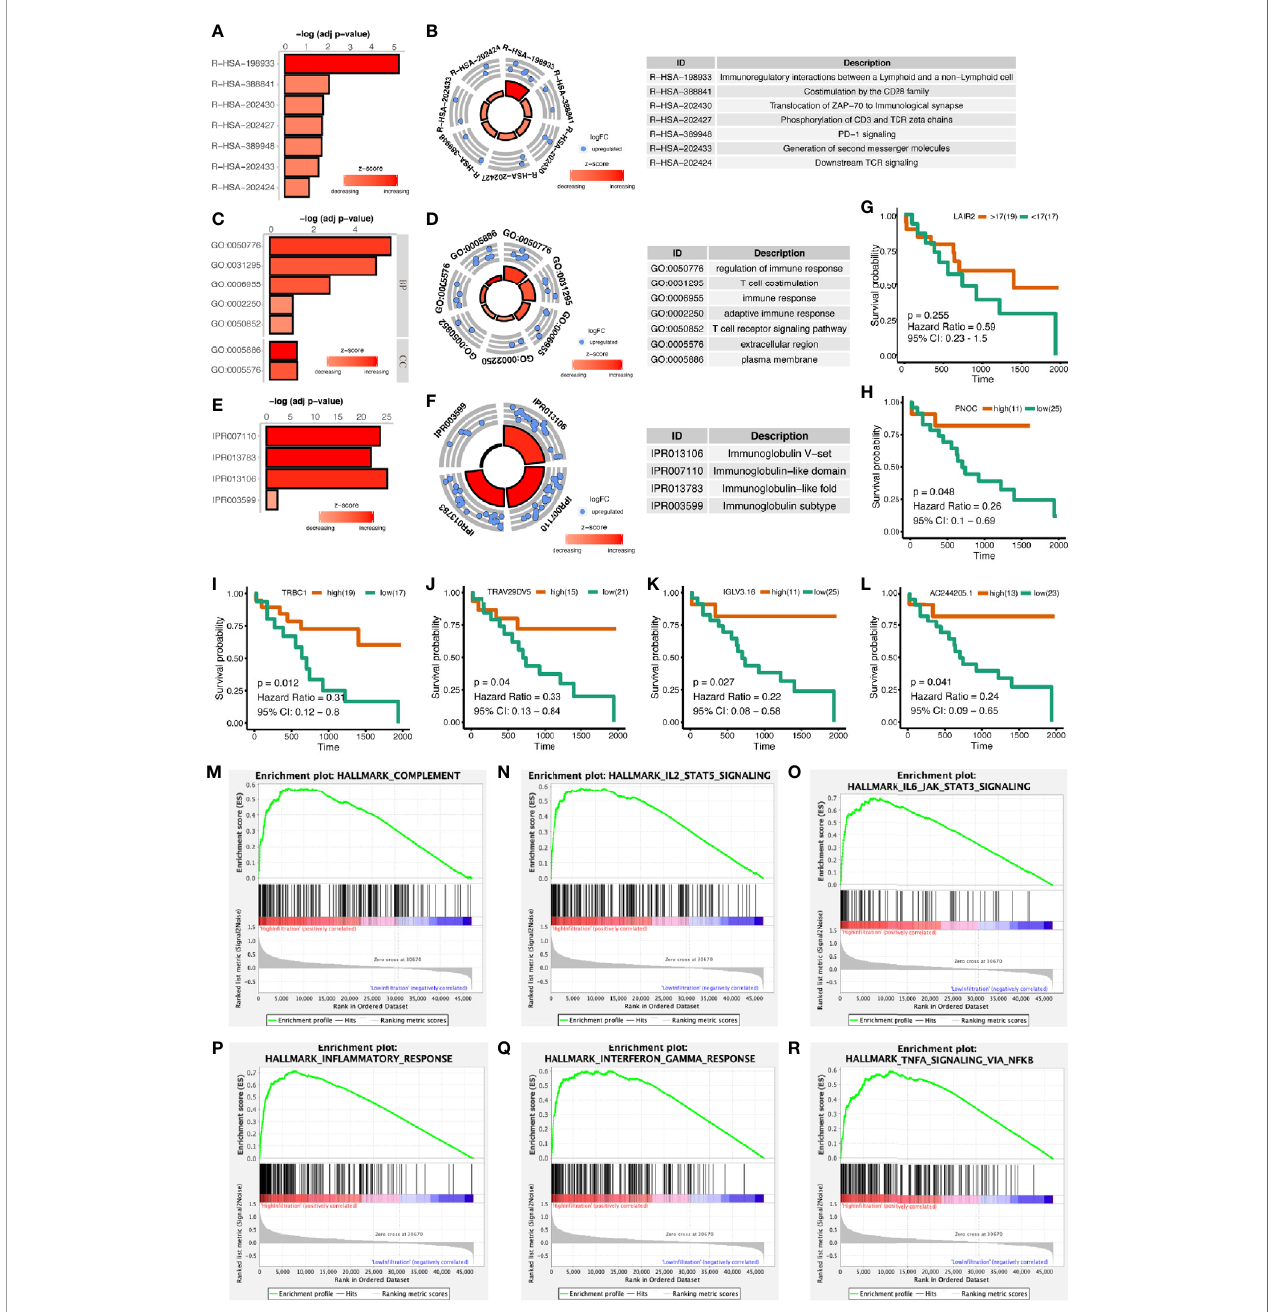
FIGURE 3 | Functional Enrichment of Differentially Expressed Genes Between High- and Low-Immune In fi ltration Groups. (A, B) Pathway enrichment of differentially expressed genes in REACTOME database. (C, D) Gene ontology enrichment of differentially expressed genes. (E, F) Protein function enrichment of differentially expressed genes. (G – L) Among differentially expressed genes, PNOC, TRBC1, TRAV29DV5, IGLV3.16, and AC244205.1 were signi fi cantly correlated with CCA patients ’ overall survival, while LAIR2 did not achieve signi fi cance. (M – R) Signatures of complement pathway, IL2-STAT5 pathway, IL6-Jak-STAT3 pathway, in fl ammatory response pathway, interferon-gamma response pathway, and TNF via NFKB pathway were highly enriched in high-immune in fi ltrated